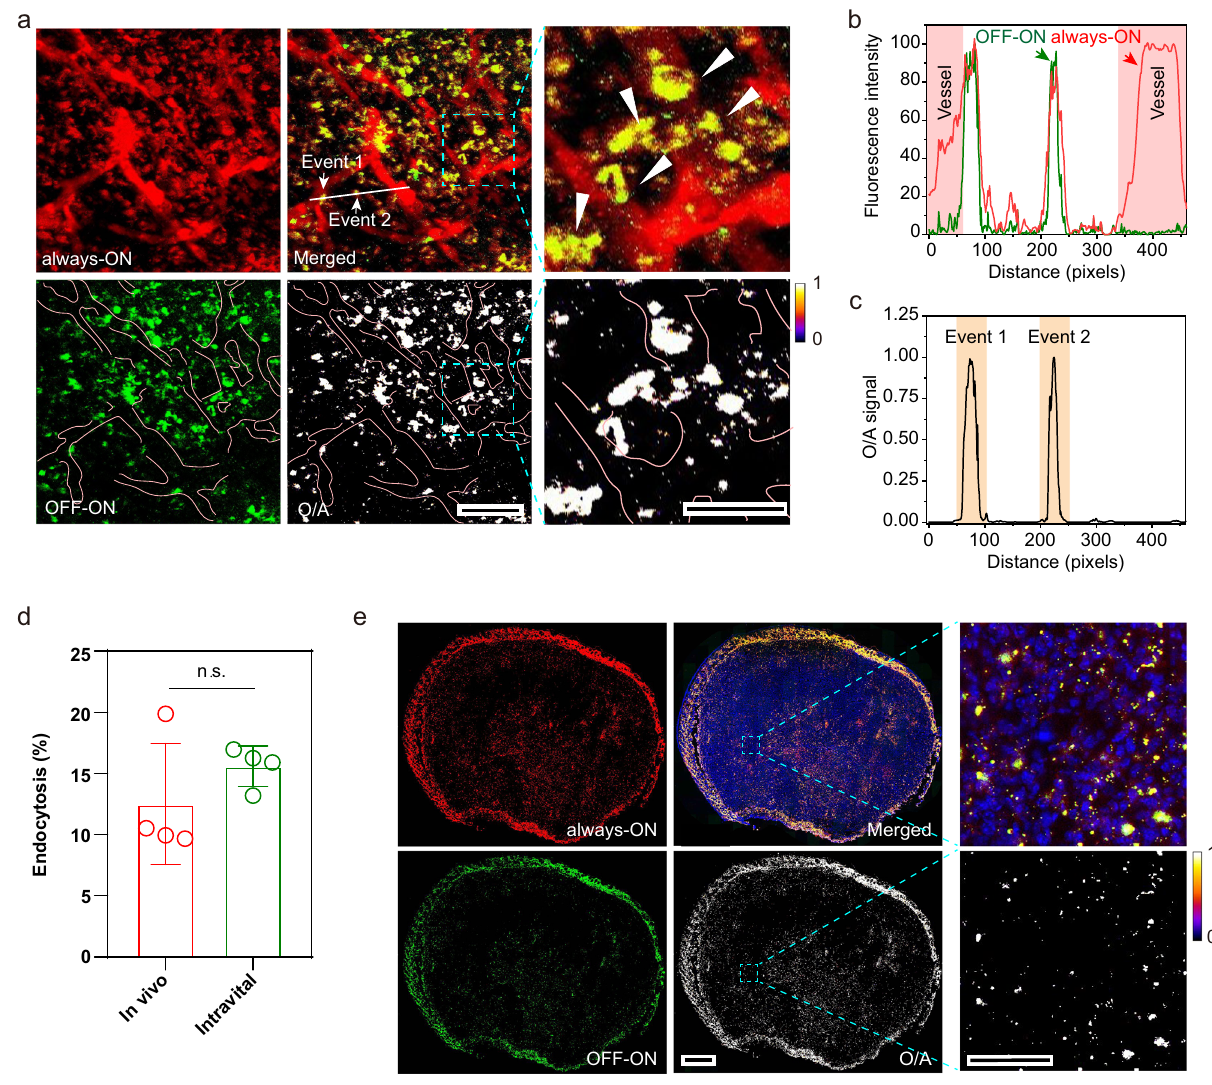
Fig. 4 Spatial resolution of BiRN nanoparticle microscopic distribution in vivo and ex vivo. a Intravital images of tumours at 3 h post-injection of BiRN (red, Cy3.5; green, BDP; yellow, colocalization of Cy3.5 and BDP; white, internalised nanoprobes). Pink lines outline the tumour vessels, and white arrows indicate intratumoural cells taken up BiRN. Scale bar, 50 μ m; insets, 25 μ m. b The fl uorescence pro fi les of two modules along the white line in merged channel of a. c O/A signal indicates endocytic events along the white line in a . d Endocytosis percentages of nanoparticles in 4T1 tumour were quanti fi ed by BiRN through two imaging methods. Data were presented as mean ± s.d. ( n = 4 biologically independent mice), n.s. not signi fi cant, two-sided Student t - test. e Whole-mount imaging analysis of BiRN distribution and internalisation for tumour slices from 4T1 tumour-bearing mice at 24 h post-administration of BiRN. Scale bar, 800 μ m. The insets are zoom-in images of squares region. Scale bar, 50 μ m. (red, Cy3.5; green, BDP; blue, nucleus; yellow, colocalization of Cy3.5 and BDP; white, internalised